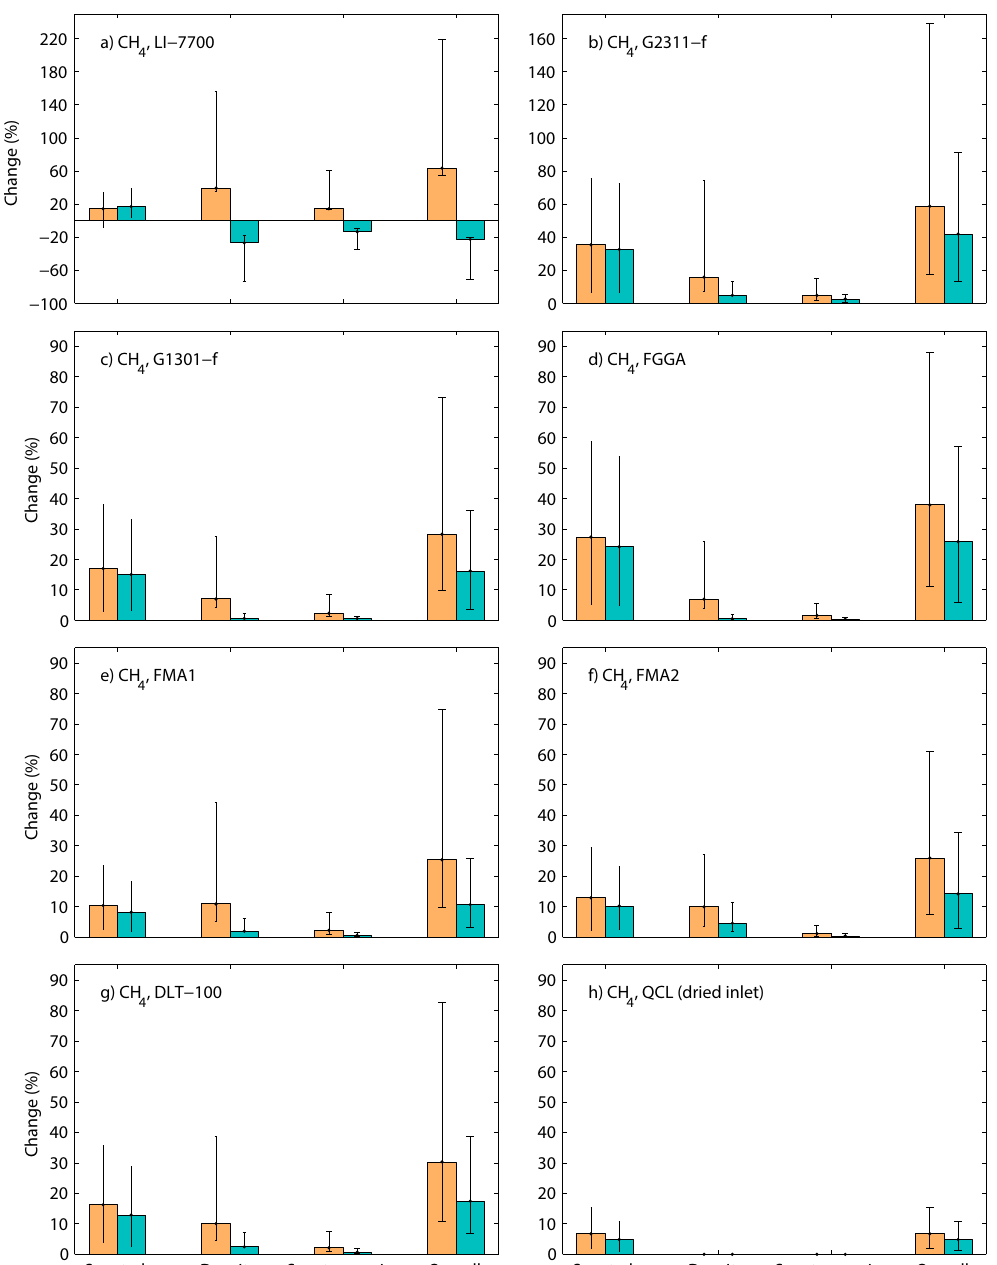
Figure 8. Change in CH 4 flux after applying different corrections. The values are given as a percentage of raw uncorrected flux. Bold bars give the median and error bars give the 25th and 75th percentile values. Light brown bars show daytime data (sun elevation angle > 0 ◦ ) and light blue bars show nighttime data (sun elevation angle < − 3 ◦ ). Bars on the far right show the overall effect. Negative value means that the correction is increasing downward fluxes, positive that it is increasing upward fluxes. Note the changing scale on the y axis.